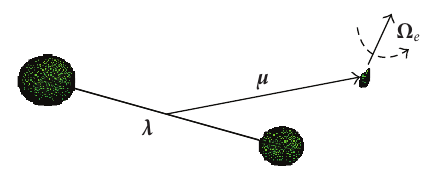
Figure 2.1. Gyrostat in the three-body